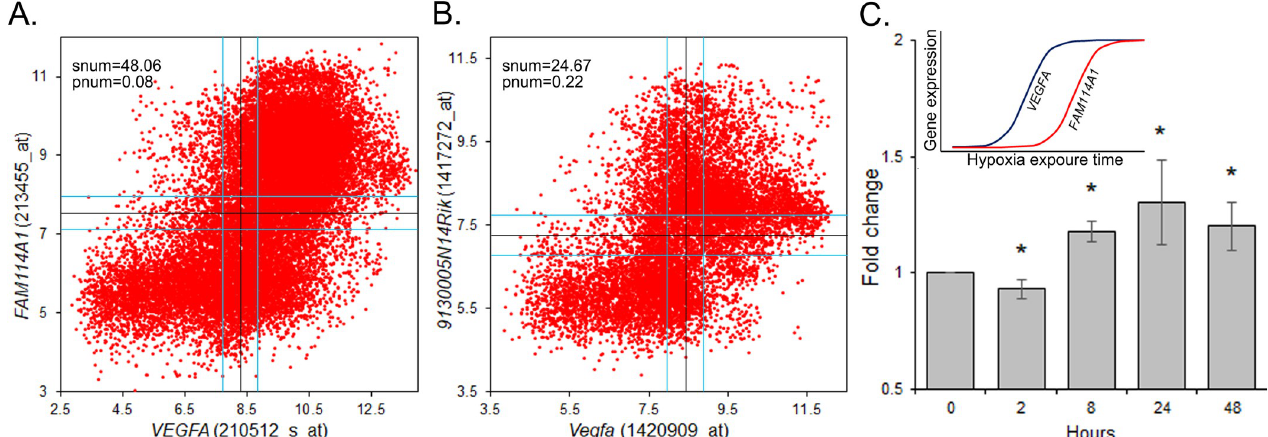
Fig 2. Identification of FAM114A1 as a novel hypoxia responsive gene. (a) Scatter plot depicting the expression profile of VEGFA (probe ID, 210512_s_at; x- axis) and FAM114A1 (probe ID, 226697_at; y-axis) in n = 25,955 ‘human’ samples. (b) Scatter plot depicting the expression profile of Vegfa (probe ID, 1420909_at; x-axis) and Fam114a1 (9130005-N14Rik, probe ID, 1417272_at; y-axis) in n = 11,758 ‘mice’ samples (Correlation = 0.451606). (c) RT-PCR results depicting expression level of FAM114A1 under normoxia (21% O 2 ) and at 2, 8, 24 and 48 hours of constant 1% O 2 measured in HPAEC. Insert, gene expression dynamics of VEGFA and FAM114A1 along the boolean path. ( � , P < 0.05).